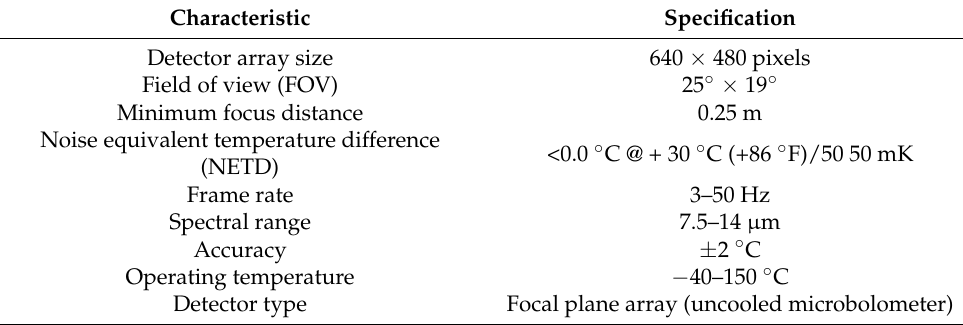
Table 1. Technical data of FLIR A615 IR camera.